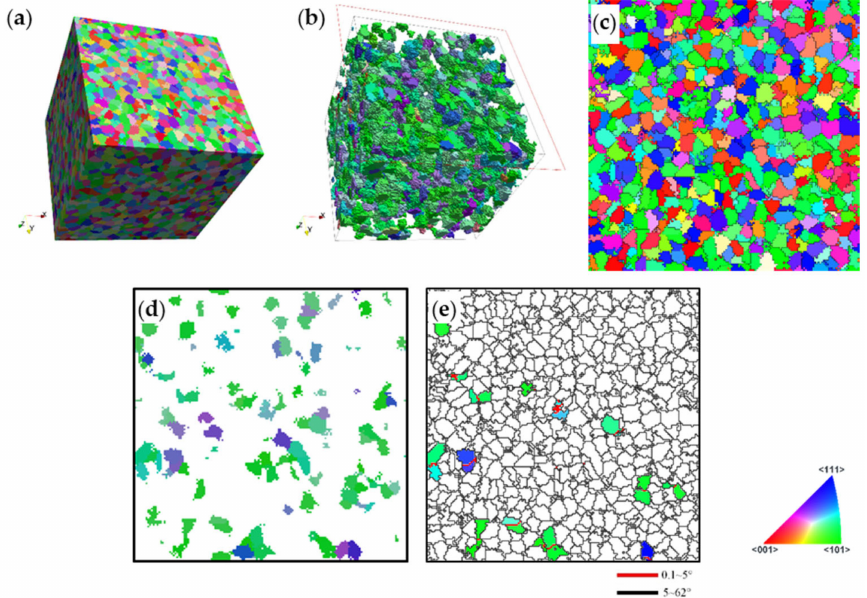
Figure 15. Comparison between 3D and 2D modeling of the texture-induced grain coalescence. ( a ) The polycrystal of initially random orientation distribution after a shear strain of 2, presented in the initial 3D cube. ( b ) The coarsening population part of the polycrystal. ( c ) The IPF map of the top surface of the polycrystal. ( d ) Grains that are coalescing with others being in the top surface in 3D, and the same in ( e ) in